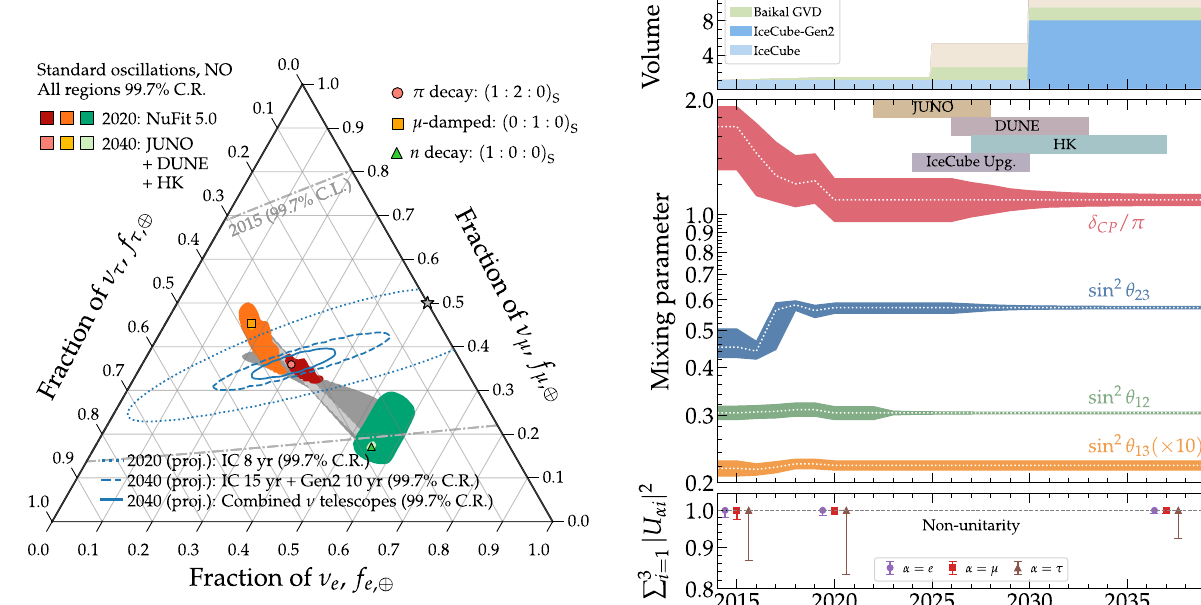
mixing angles, and unitarity constraints. Top: effective volume of high- energy neutrino telescopes stacked. Middle: Uncertainties in the neu- trino oscillation parameters as a function of time. Experiments relevant for neutrino oscillation parameter measurements are also shown with their proposed timelines. Bottom: Constraints on the unitarity of the neutrino mixing matrix for different neutrino flavor rows. Figures are from Ref.